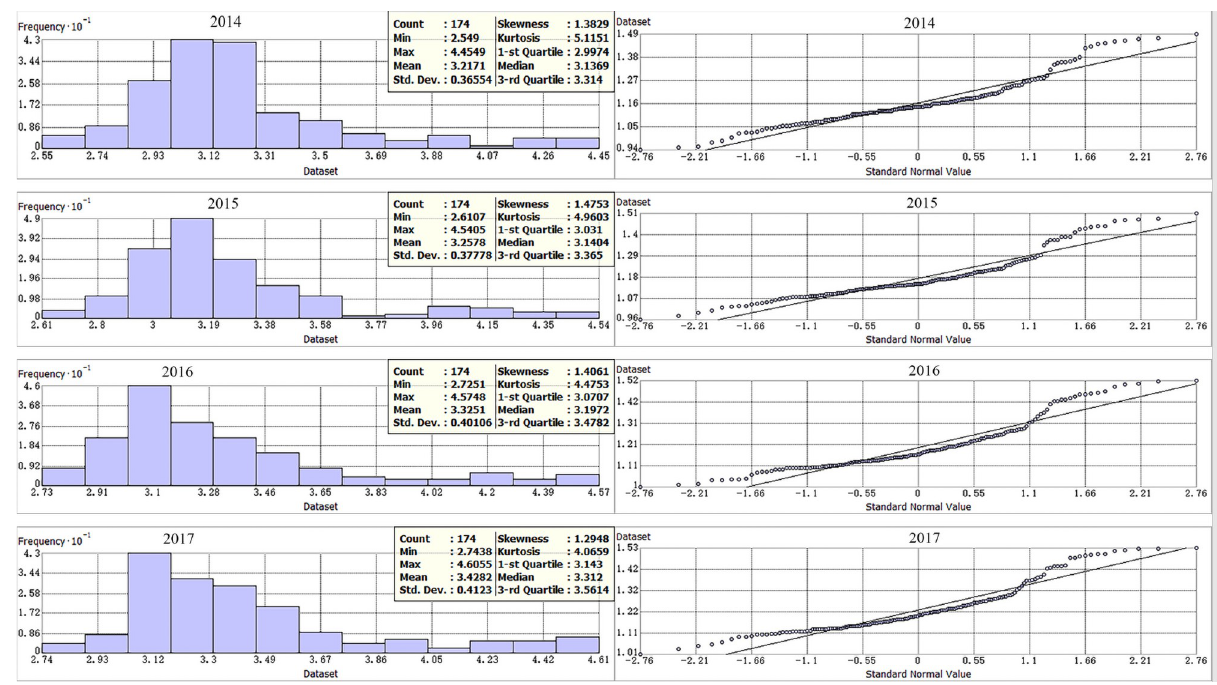
Fig 2. The histogram of residential land price samples and QQ-plot distribution map from 2014 to 2017.